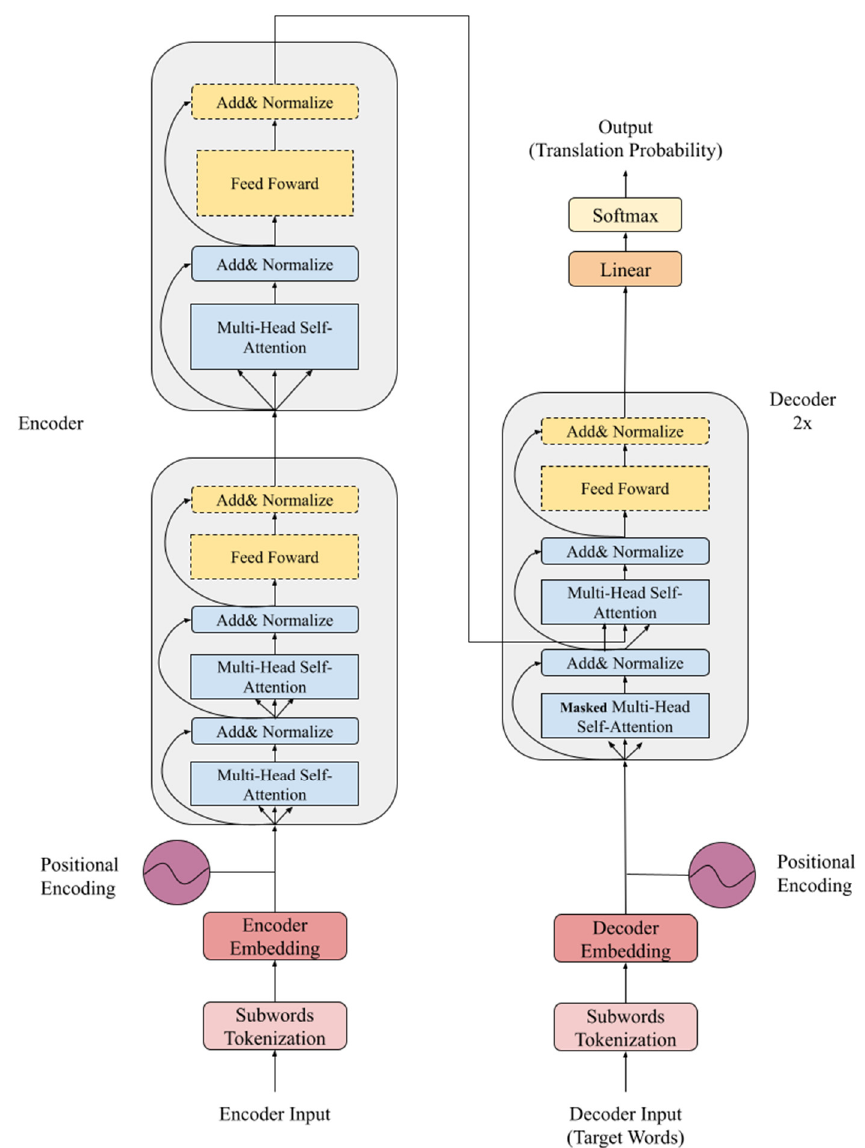
Figure 5. Construction of the X-Transformer model.